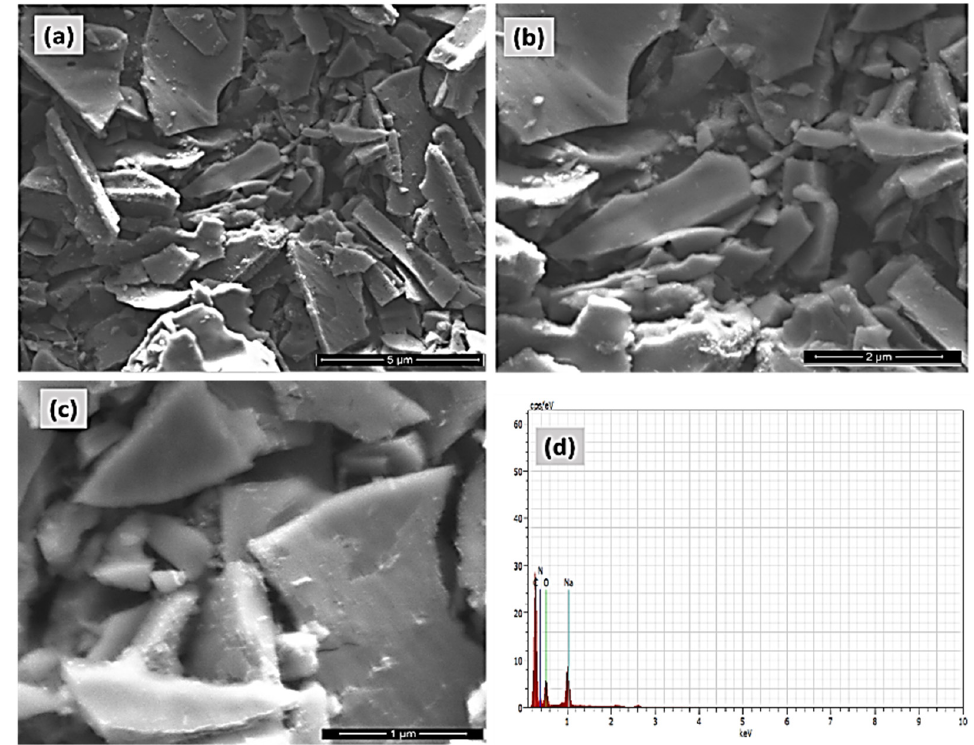
Figure 5. FE-SEM micrograph pictures of ( a – c ) Porous graphitic carbon nitride (P-GCN), and ( d ) EDAX and elemental analysis of P-GCN.